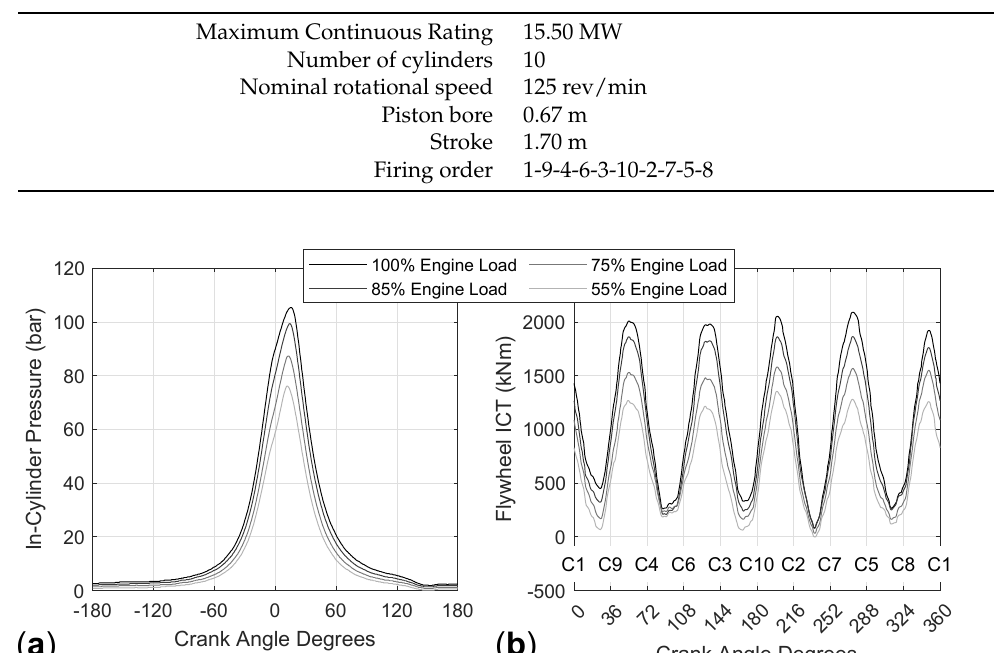
Figure 1. Measured ( a ) in-cylinder pressure and ( b ) flywheel ICT, at four engine loads of 100%, 85%, 75% and 55%. Firing cylinders are marked as C1, C2, ...